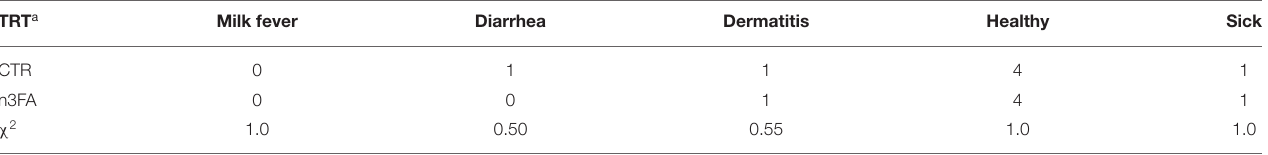
TABLE 2 | Incidence of diseases observed between − 35 and 21 days from calving in dairy cows infused with 150ml of sterile saline or 150ml of a 10% solution containing purified fish oil rich in long-chained omega-3 fatty acids at 12, 24, and 48h after calving. TRT a Milk fever Diarrhea Dermatitis Healthy Sick CTR 0 1 n3FA